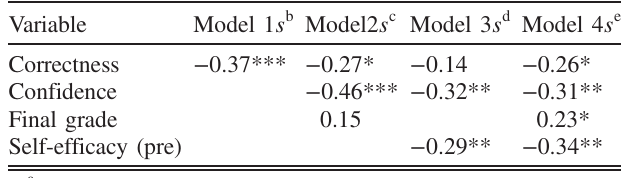
TABLE IV. Fitted linear regression models explaining variation in confusion index by selected variables of student learning and engagement, spring 2011 ( N ¼ 88 ).